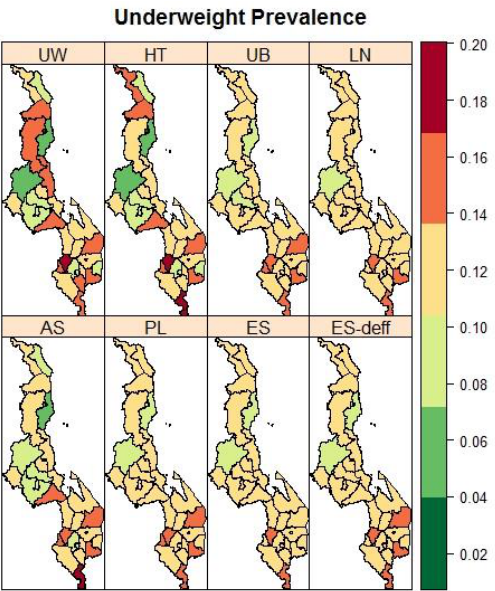
Figure 4. Maps of the observed (UW: unweighted and HT: Horvitz Thompson) and spatial estimated prevalences of underweight (UB: Unadjusted Binomial estimator (Model 1), LN: Logit-normal estimator (Model 2), AN: Arcsine-square root transformation estimator (Model 3), PL: Pseudo-likelihood estimator (Model 4), ES: Effective Sample size estimator (Model 5), and ES-deff: Effective Sample size estimator using design effect (Model 6)) by the district in Malawi using 2015-16 MDHS.